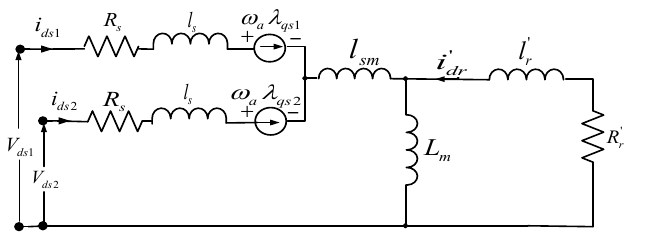
Figure 3. d-axis equivalent circuit of a SPIM in arbitrary reference frame.